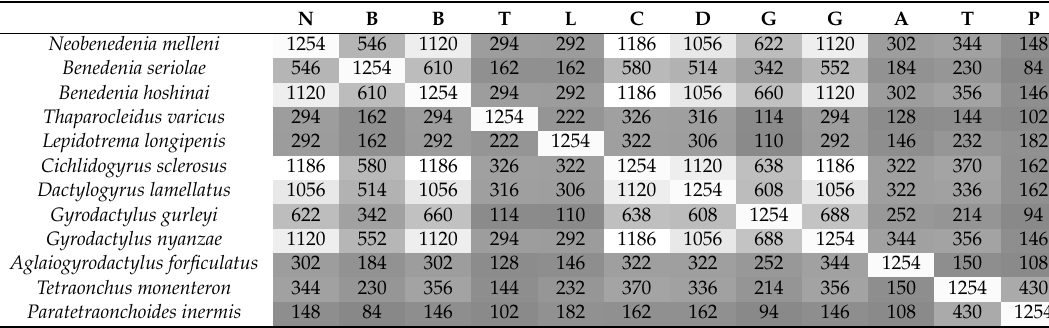
Table 2. Pairwise common interval comparison of mitochondrial gene orders among 12 monopisthocotylean species (only one representative is shown for species with identical gene orders), based on the order of all 36 genes. Scores indicate the similarity between gene orders, where 1254 represents an identical gene order. Shading indicates the level of similarity: light to dark = similar to dissimilar. N B B T L C D G P Neobenedenia melleni 1254 1120 294